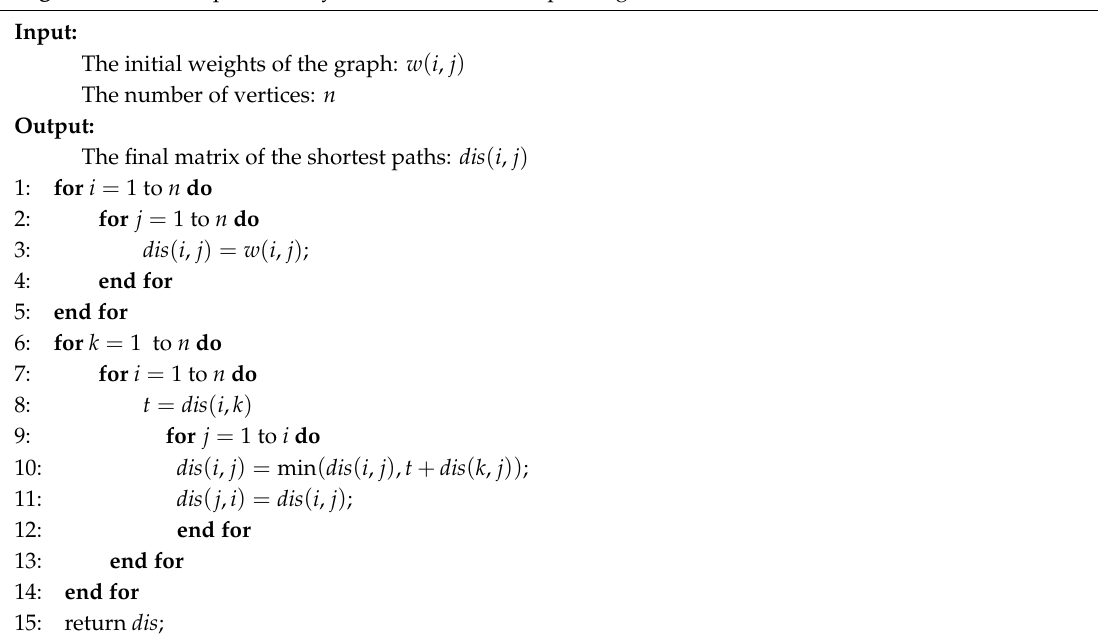
Algorithm 2 The improved Floyd-Warshall’s shortest path